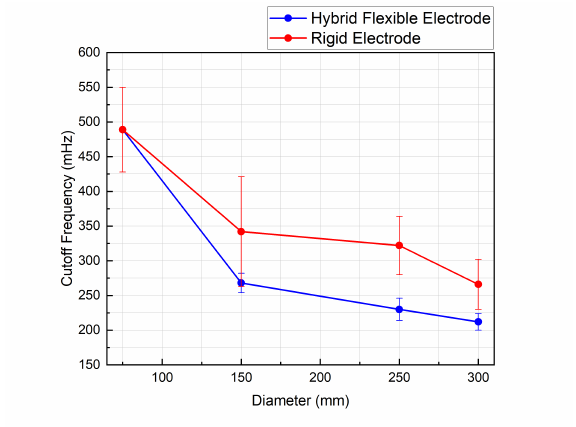
Figure 9. Average cut-off frequency vs. body diameter for hybrid flexible and rigid electrodes. Average measurements over 5 samples of each electrode type.